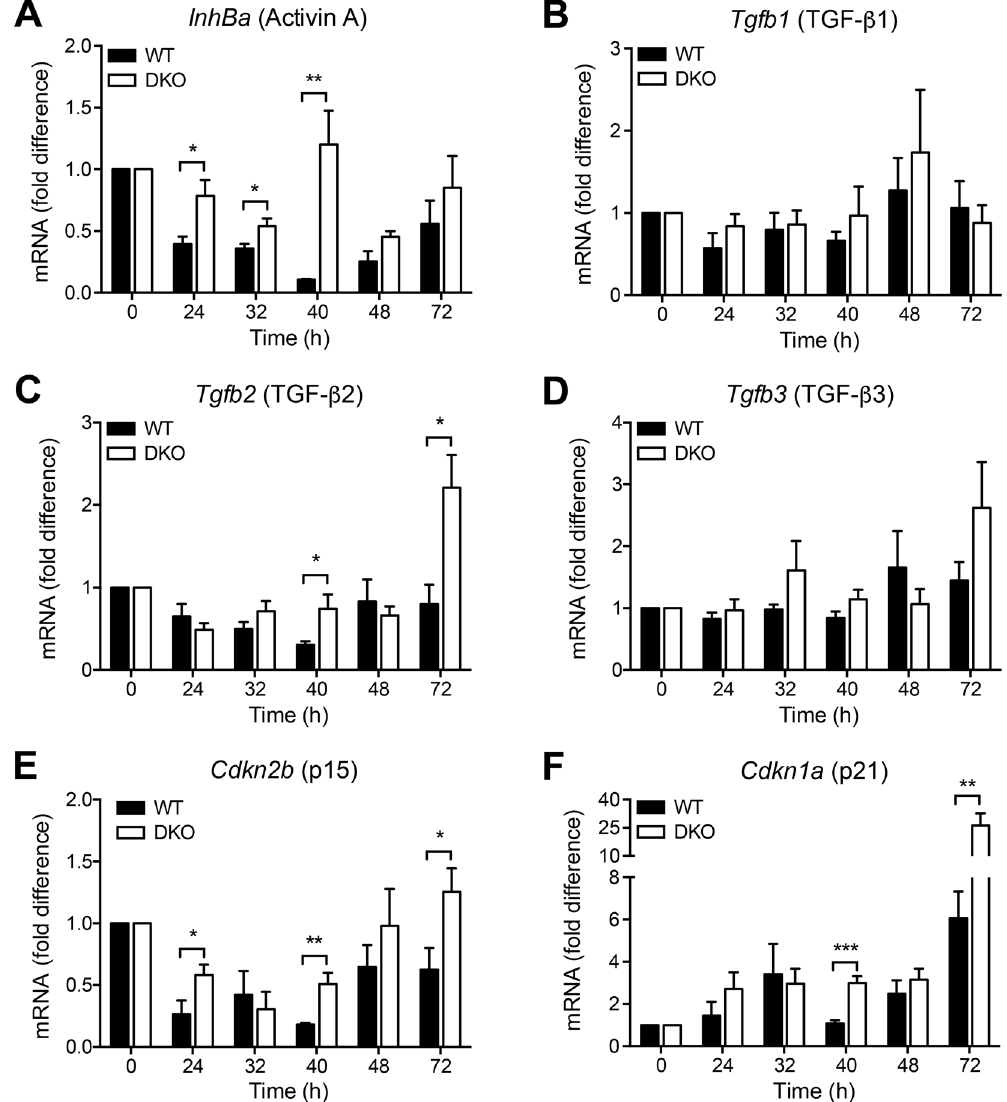
Figure 5. Lack of cytosolic nucleic acid sensing enhances expression of cell cycle inhibitors. Hepatic mRNA expression of activin A (A) , TGF- β 1 (B) , TGF- β 2 (C) , TGF- β 3 (D) , p15 (E) , and p21 (F) at various time points after partial hepatectomy is depicted as fold difference relative to untreated livers. For each time point and in each group samples from 5 to 7 independent mice were analysed. * P < 0.05, ** P < 0.01 *** P < 0.001 (two- tailed unpaired Student’s t-test or the Mann-Whitney U